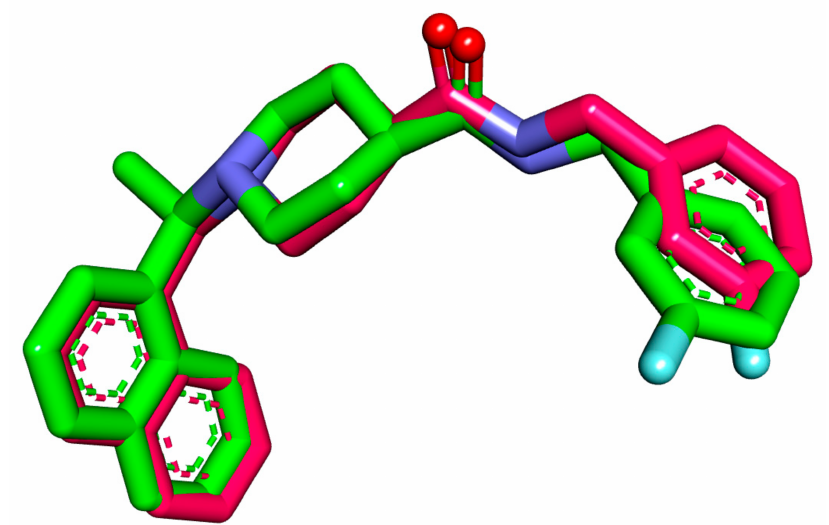
Figure 4. Superimposition of the redocked pose colored in pink against the co-crystallized one colored in green ( S88 ) in PLpro active